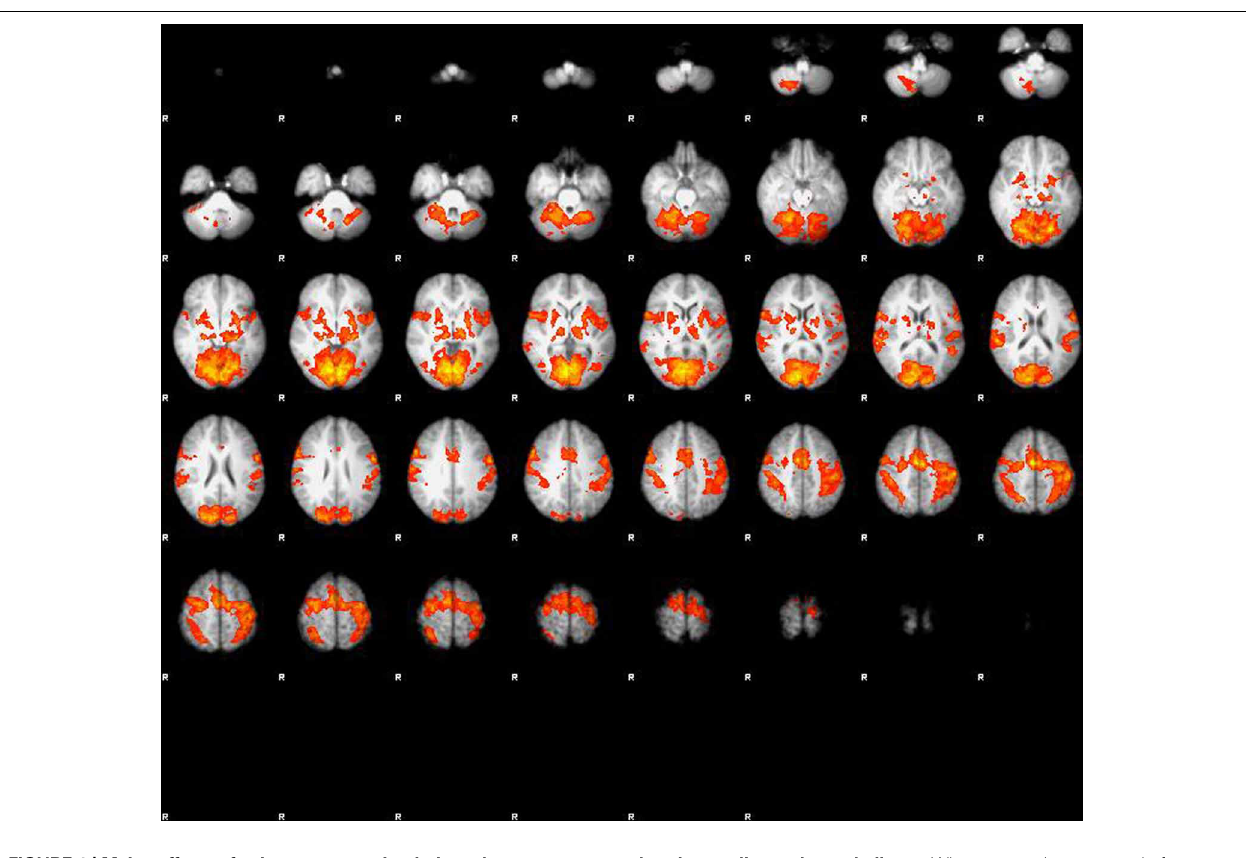
basal ganglia and cerebellum. When properly corrected for multiple comparison or corrected voxel level ( p < 0 . 05) there is no effect of